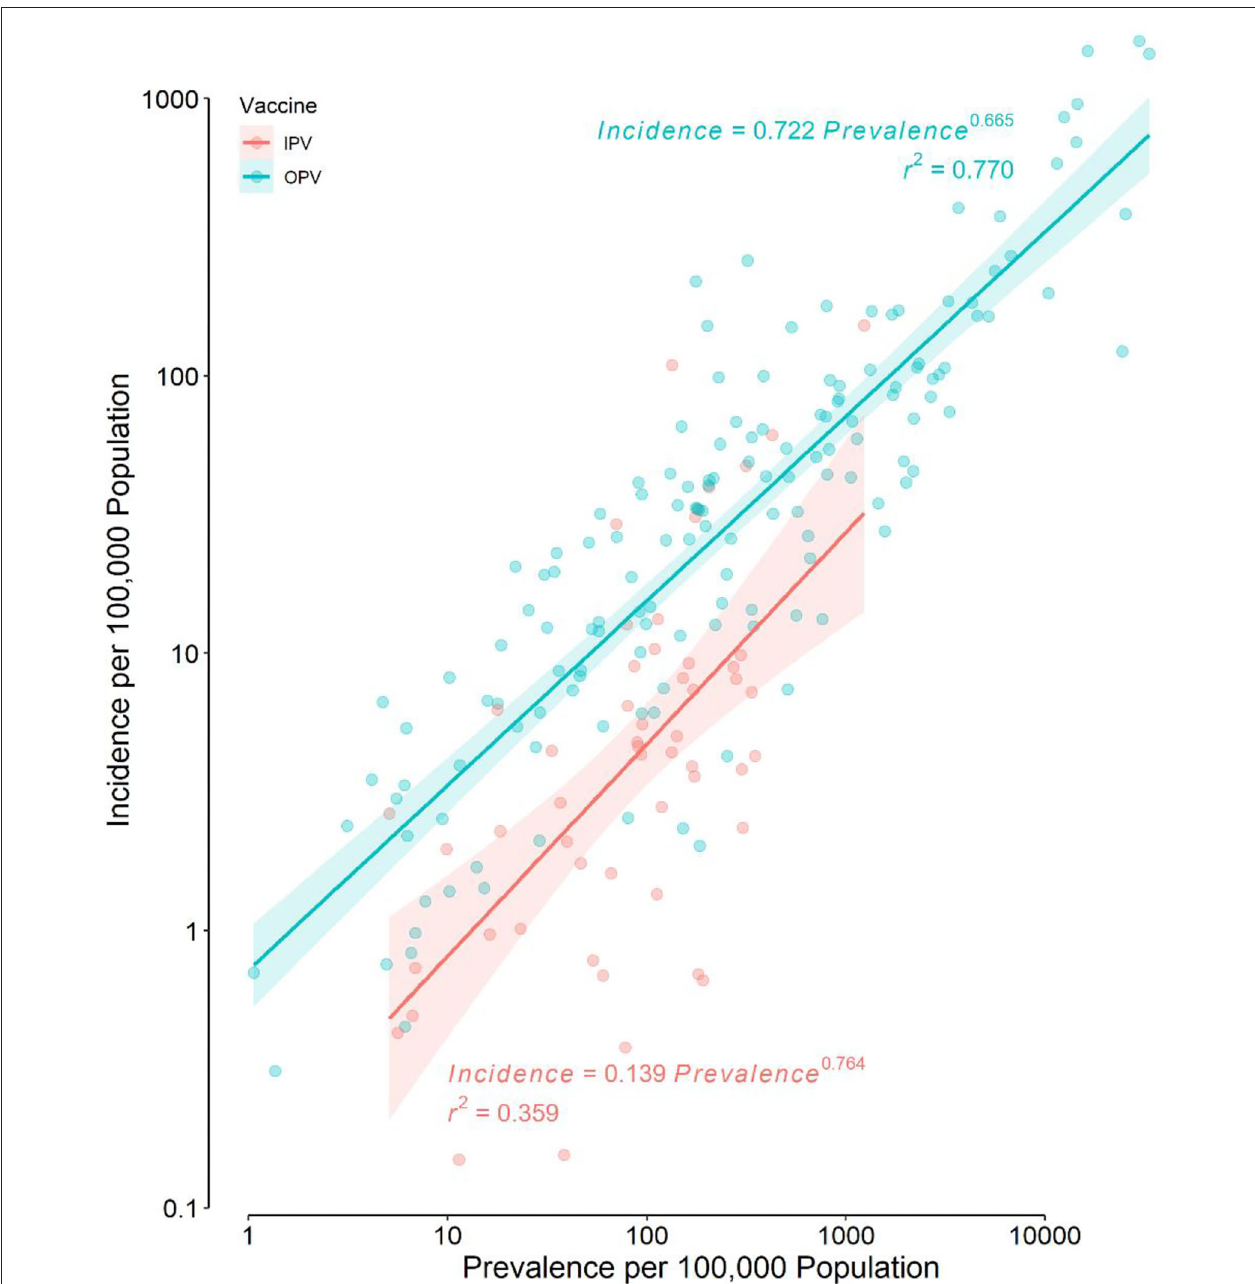
FIGURE 2 | Scatter plot of the incidence of HIV/AIDS in children aged < 1 year against the prevalence of HIV/AIDS in women aged 15–49 years in the original dataset. Note that the scale of both axes is logarithmic. The regression lines and their 95% confidence bands are also presented for each type of polio vaccine